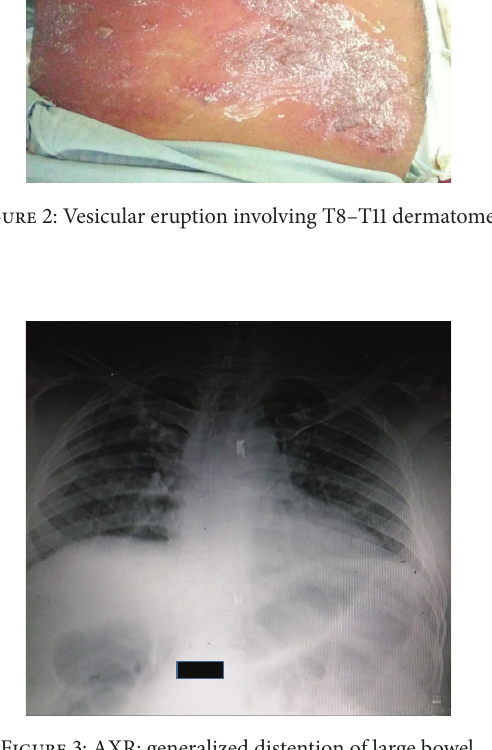
findings characteristic of paralytic ileus. Colonoscopy was performed and showed normal colon up to the cecum with no obstructing